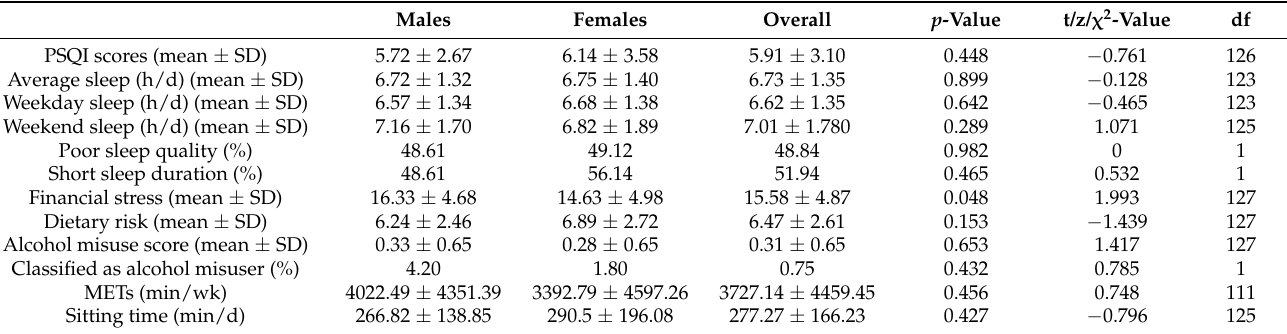
Table 3. Gender comparisons of health